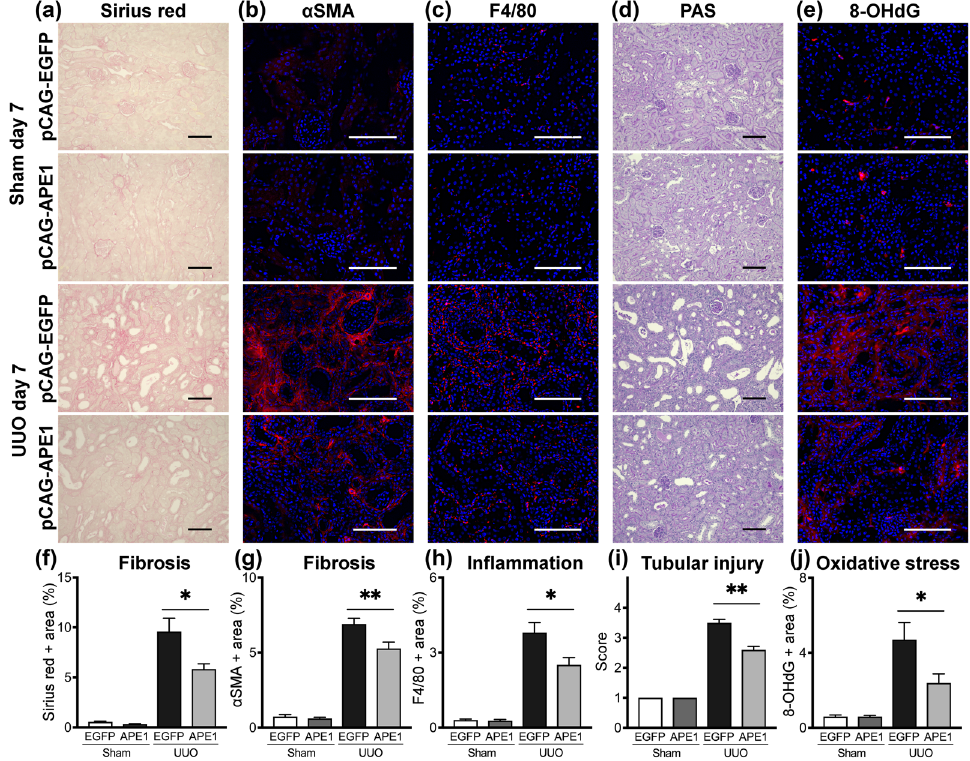
Figure 2. pCAG-APE1 injection suppresses interstitial fibrosis, inflammation, and oxidative stress. Mice were subjected to unilateral obstructed ureter (UUO) or sham procedures and injected with pCAG-APE1 or pCAG- EGFP (control) vectors. ( a ) Sirius red-stained images of kidney cortex. ( b ) Images of α SMA-positive cells in the kidney cortex. ( c ) Images of F4/80-positive cells in the kidney cortex. ( d ) Images of periodic acid–Schiff (PAS) staining in the kidney cortex. ( e) Images of 8-hydroxy-2 ′ -deoxyguanosine (8-OHdG)-positive cells in the kidney cortex. ( f–j ) Quantification of fibrosis based on Sirius red staining, myofibroblasts detected by α SMA, inflammation identified by F4/80 expression, tubular injury based on PAS staining, and oxidative stress detected by 8-OHdG. Scale bars: 100 μ m. n = 5–6/group. * P < 0.05, ** P < 0.01 (ANOVA with Tukey’s post hoc analysis). Data are presented as the mean ±